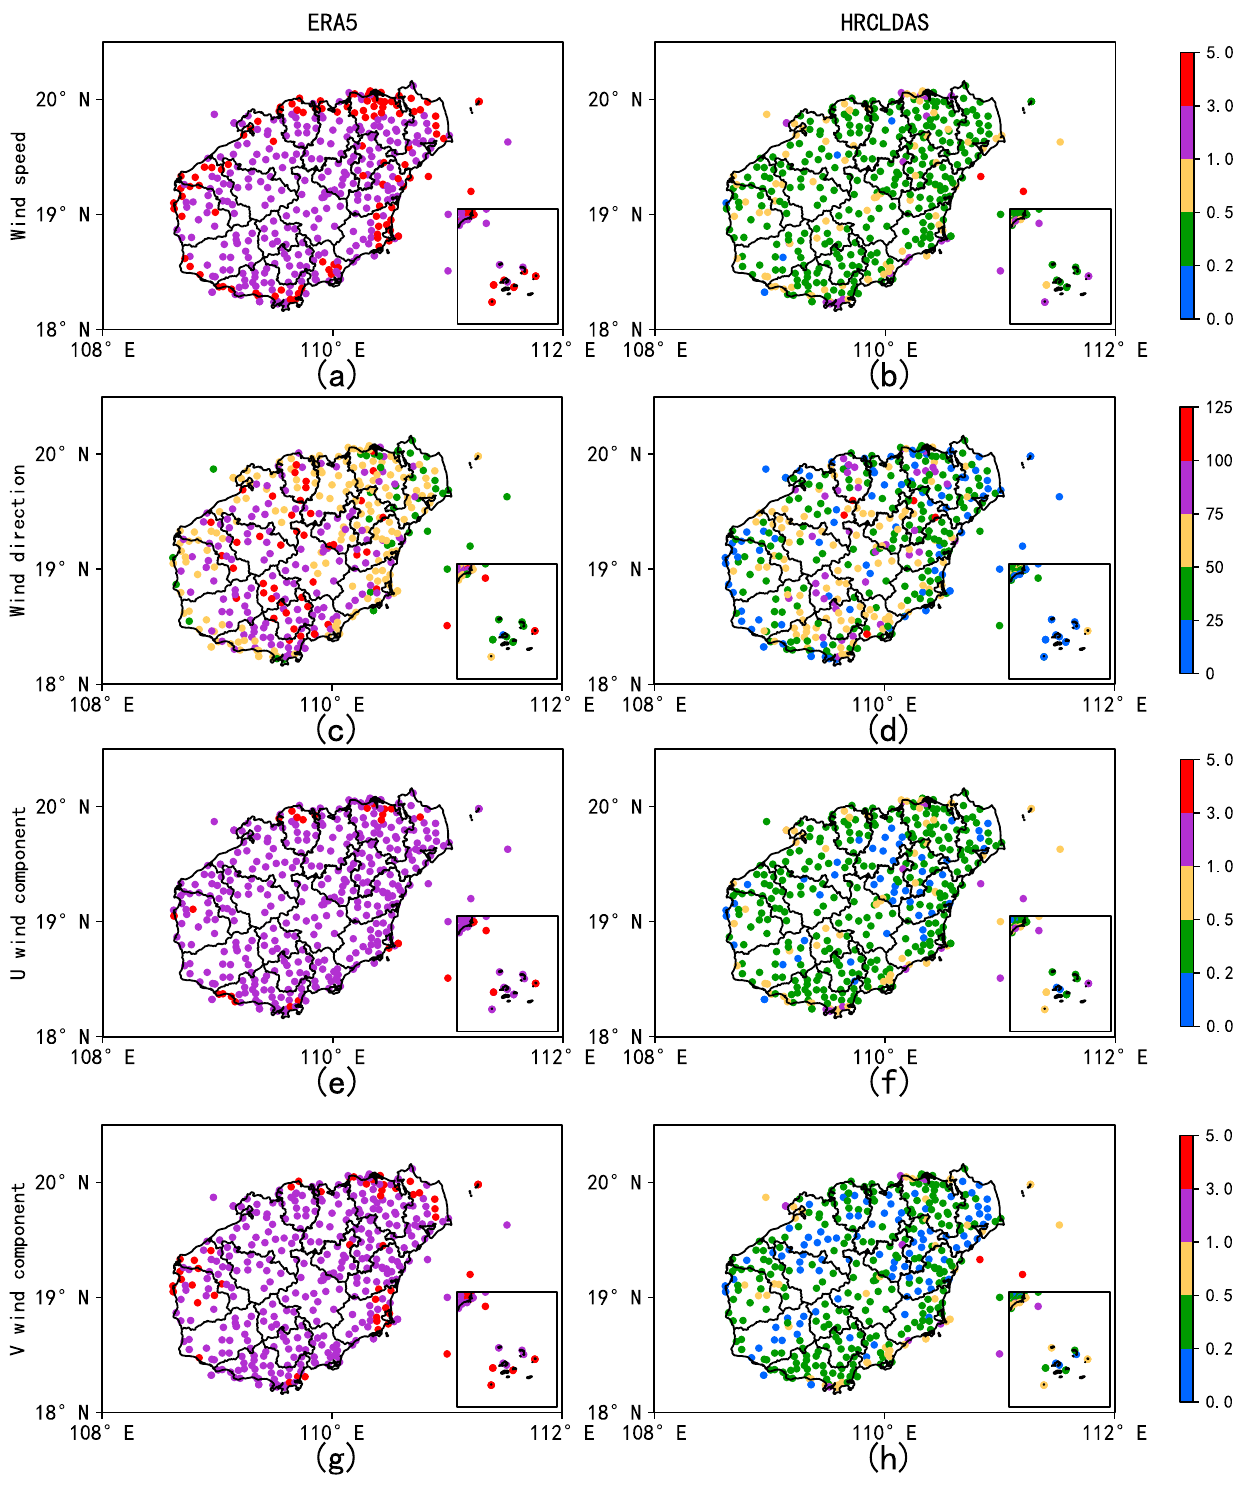
Figure 3. RMSE spatial distribution. ( a ) ERA5 near-surface wind speed, ( c ) ERA5 wind direction, ( e ) ERA5 U component, ( g ) ERA5 V component; ( b ) HRCLDAS near-surface wind speed, ( d ) HRCLDAS wind direction, ( f ) HRCLDAS U component, and ( h ) HRCLDAS V component.